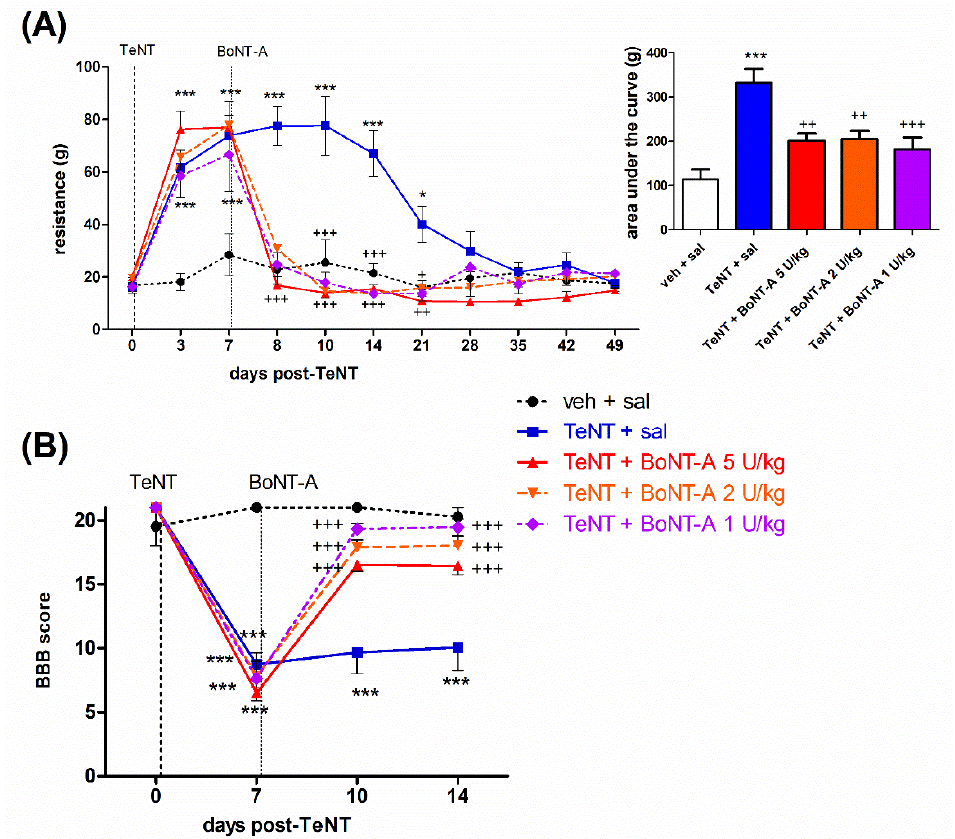
Figure 1. The fast-onset antispastic effect of botulinum toxin type A (BoNT-A) on tetanus toxin (TeNT)-evoked hind limb rigidity and locomotor deficit in rats. The BoNT-A (1–5 U/kg) intramus- cular (i.m.) injection into gastrocnemius reduces the preestablished TeNT (1.5 ng, i.m.)-evoked re- sistance to ankle dorsiflexion (reaching a 90° tibiotarsal angle) ( A ), and the locomotor deficit as- sessed by the Basso Beattie Bresnahan (BBB) scale ( B ). Veh, vehicle; sal, saline i.m. treatment. Hori- zontal bars indicate the time points of TeNT and BoNT-A i.m. application. N = 8 to 9 animals/group; mean ± SEM, * and ***: p < 0.05 and <0.001 vs. veh + sal, +, ++ and +++: p < 0.05, <0.01 and <0.001 vs. TeNT + sal (two-way RM ANOVA, followed by Bonferroni’s post hoc test; p < 0.05 considered sig- nificant).